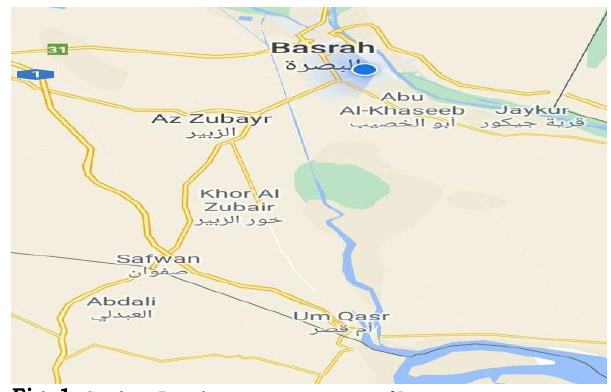
Fig. 1. Southern Basrah governorate on a map of Iraq Table 1 Uranium content in Southern Basrah Governorate soil measured up the SSNTDS